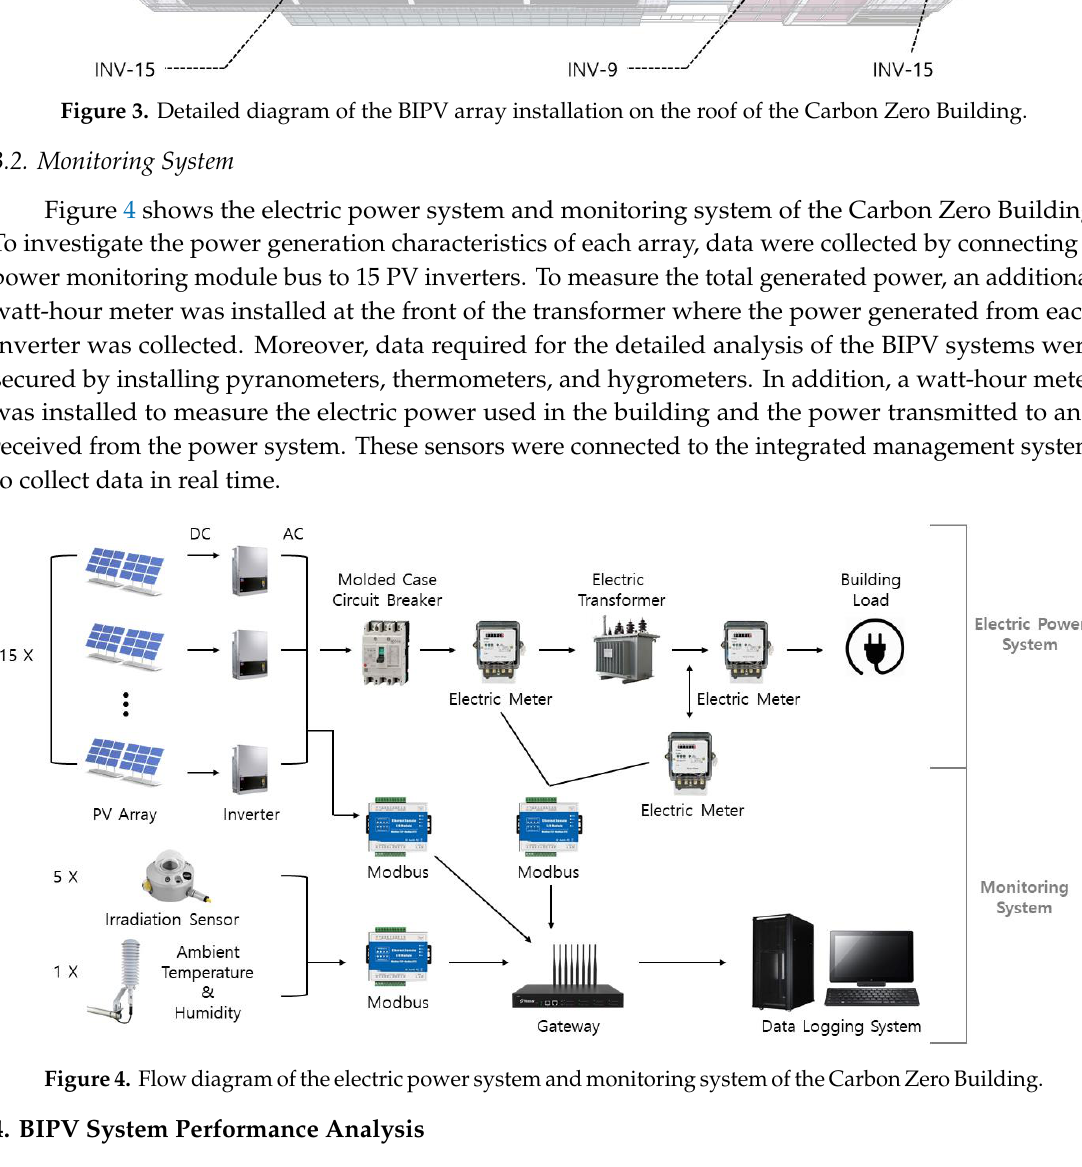
Figure 3. Detailed diagram of the BIPV array installation on the roof of the Carbon Zero Building.